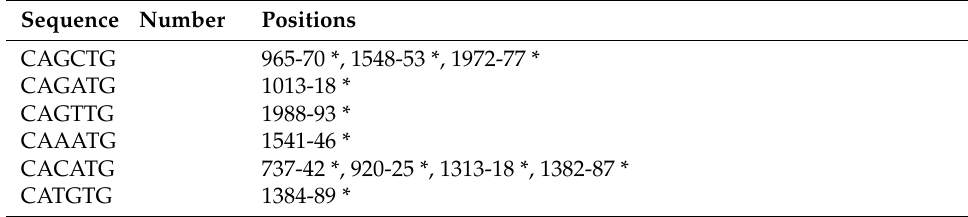
Table 6. The number and positions of E-box hexanucleotide consensus sequence (CANNTG) in SOX2 transcription unit. The asterisks indicate exonic